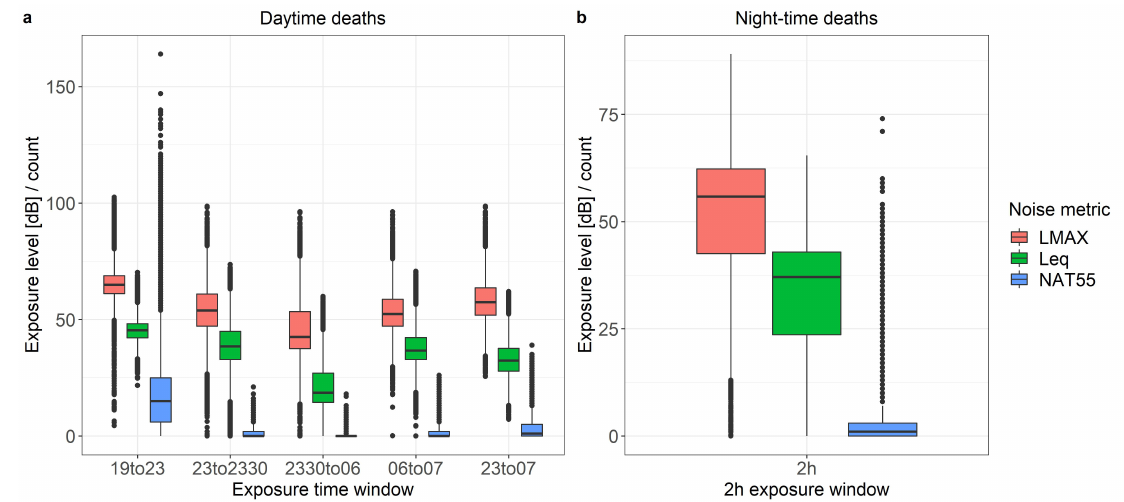
Figure 5. ( a ) Distribution of the noise exposure levels L Amax and L Aeq (in dB) as well as NAT 55 (count) for the different time windows among all events (case and control) for daytime deaths, years 2000–2015. ( b ) Distribution of the noise exposure levels L Amax , L Aeq and NAT 55 for the 2 h exposure window among the events (case and control) for nighttime deaths, years 2000–2015. The horizontal line of the box-plot represents the median value, the squares the interquartile range (IQR), and the whiskers the lower and upper limits (lower IQR value—1.5*IQR/upper IQR value +